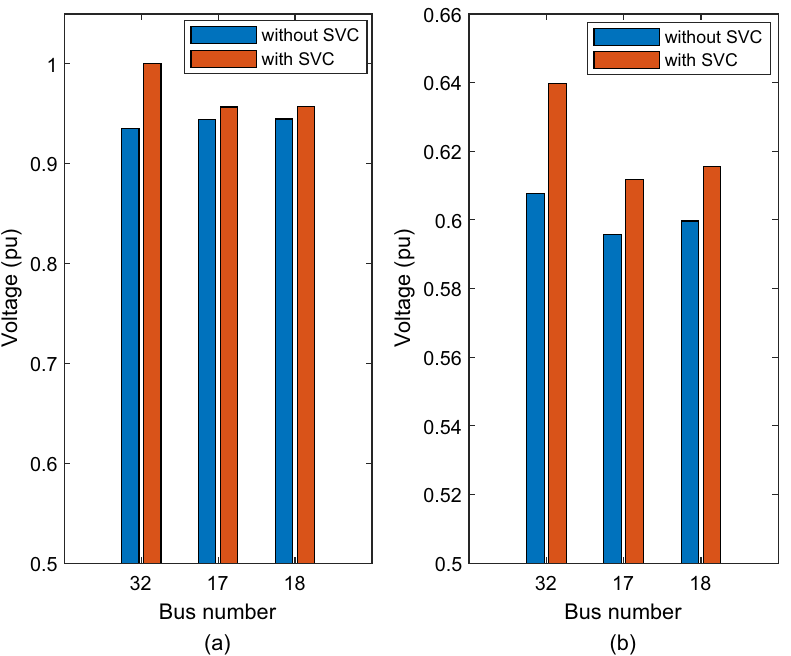
Figure 8. Voltage improvement after adding SVC at bus 32 ( a ) nominal load ( b ) heavy load.